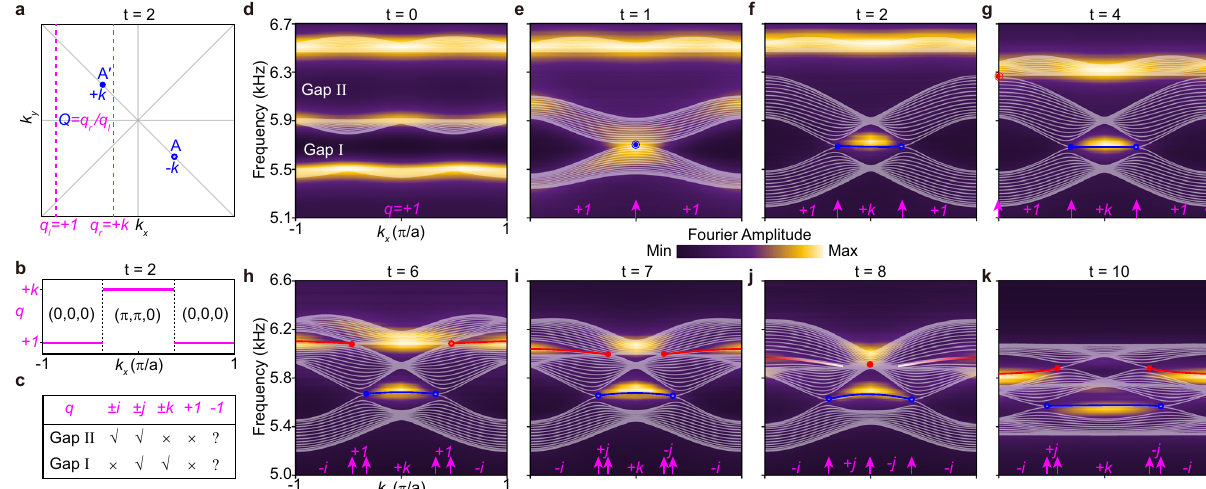
Fig.5|Edgeresponseofmulti-gapnon-abelianbraiding.a Quotientrelationthat relatesanodalcharge( Q )andthenon-Abelianchargesde fi nedfortwoconstant- k x loops ( q r and q l ). b k x evolution of the loop charge (dubbed q in general) exem- pli fi ed for the case of t =2. Zak phases of the three bands (from the lowest to the highest) are indicated for different k x intervals. c A summary of the correlation betweenthe loop charge and the presence( ☑ )orabsence( ☒ ) of the edgestates in